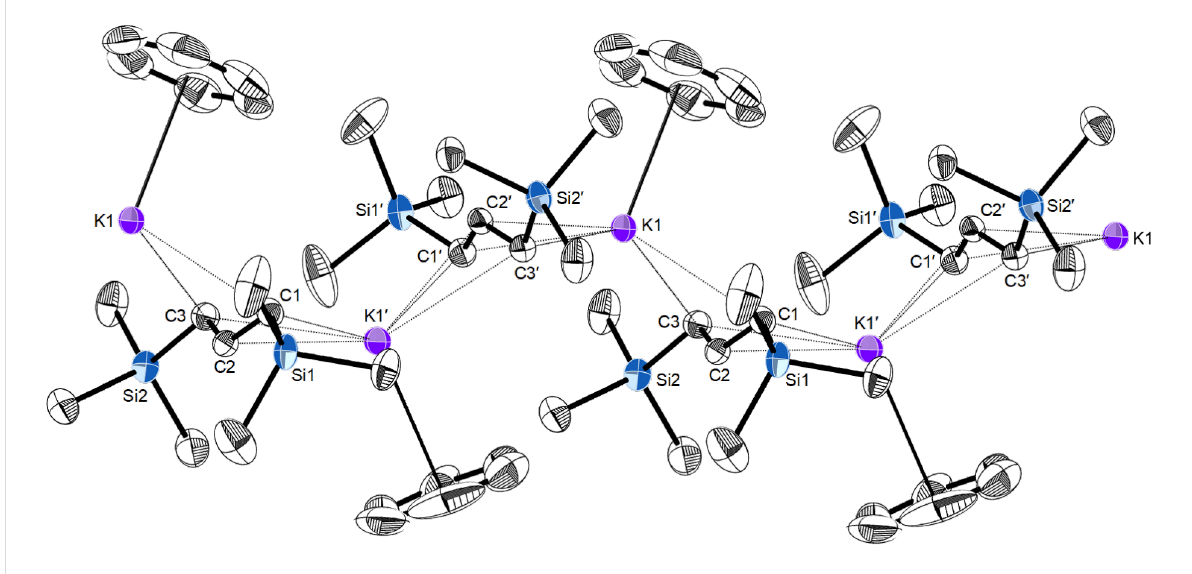
Figure 3: Portion of the polymeric chain of [(C 6 H 6 )KA'] ∞ , with thermal ellipsoids drawn at the 50% level. Hydrogen atoms have been removed for clarity. Selected distances (Å) and angles (deg): K1–C1, 3.005(3); K1–C2, 2.963(3); K3–C3, 3.128(3); K1–C1', 2.959(3); K1–C2', 2.983(2); K3–C3', 3.140(3); K1 … (C 6 H 6 centroid), 2.99(1); K1 … K1', 5.39; C1–C2–C3, 130.8(3); K1 … K1' … K1, 134.0.